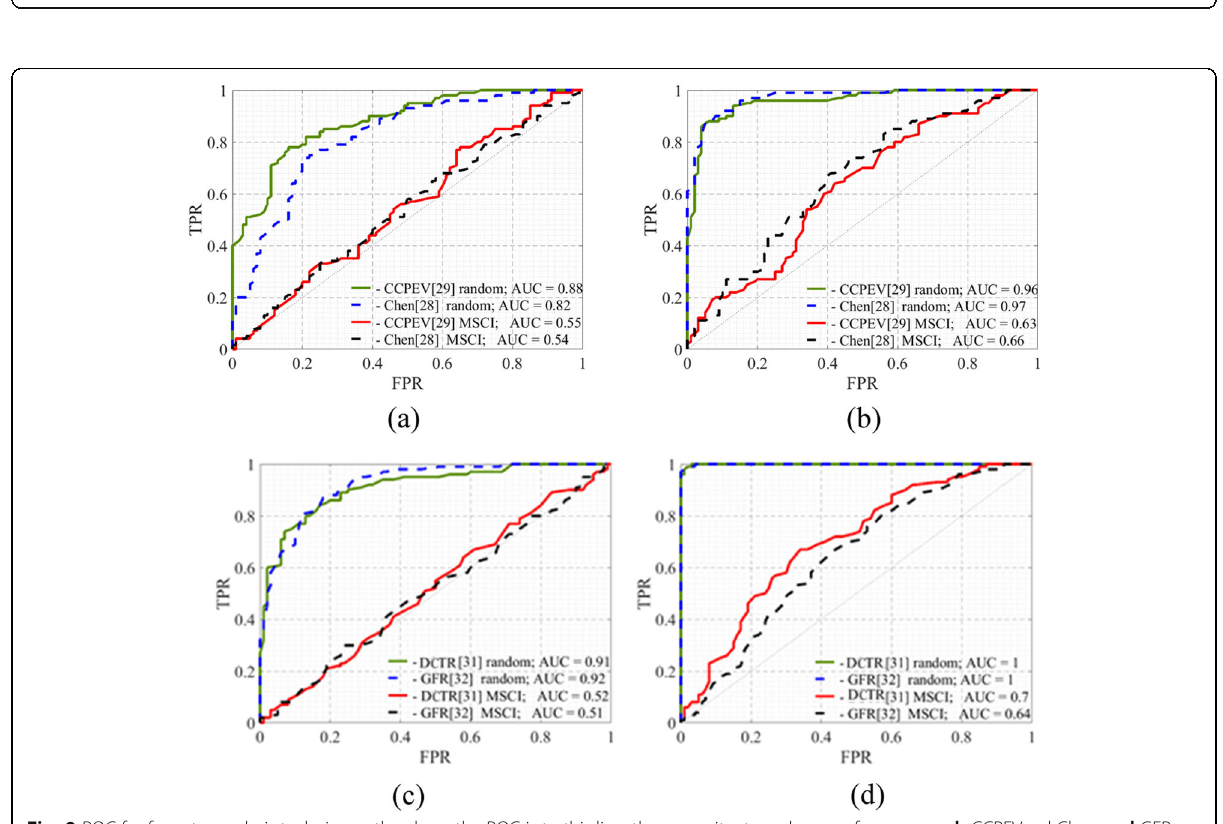
Fig. 9 ROC for four steganalysis techniques: the closer the ROC is to this line, the worse its stegnalyser performance. a , b CCPEVand Chen, c , d GFR and DCTR. The cover selection was performed with MSCI and random selection for different secret image sizes: ( a , c ): 32 × 32 and ( b , d ): 64 ×